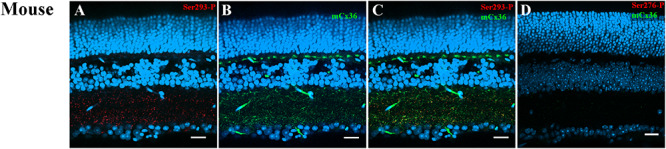
Ser293 antibody labeling patterns in mouse retina. (A–C) Labeling pattern of phospho-Ser293 antibody in vertical section of mouse retina. (A) Ser293-P antibody-labeled (red) abundant punctate structures in the inner plexiform layers (IPL) and some in the outer plexiform layer (OPL). (B) Labeling with monoclonal Cx36 antibody (green) shows the labeling of Cx36 also in the OPL and IPL. (C) Merged image of (A) and (B) shows multiple plaques identified as Ser-293-P colocalized with Cx36 antibody labeling (yellow). (D) In the negative control of Cx36 KO mouse retina, labeled punctate of Cx36 antibody and Ser293-P were absent in both OPL and IPL. Scale bar is 20 μm.